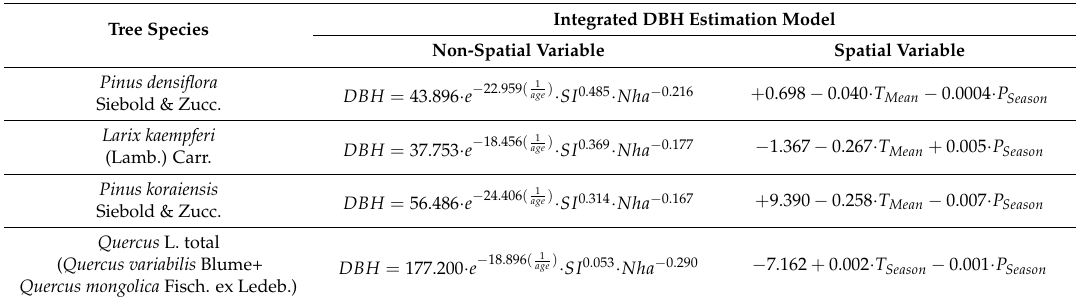
Table 7. Integrated model to estimate diameter at breast height (DBH), including climate factors, for each tree species. Integrated DBH Estimation Model Tree Species Non-Spatial Variable Spatial Variable